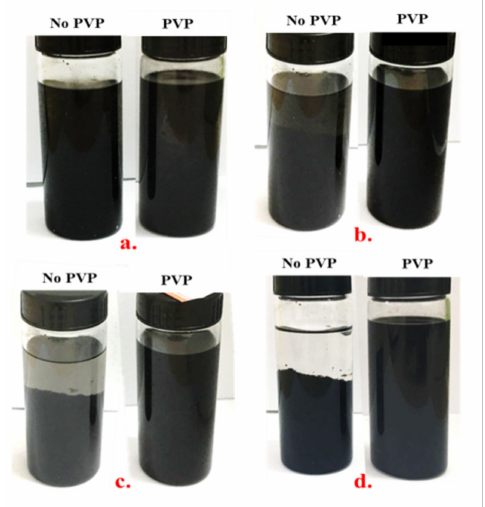
Figure 5. CNTs with and without PVP dispersion in ethanol with the time of ( a ) 0 min, ( b ) 30 min, ( c ) 1 h and ( d ) 3